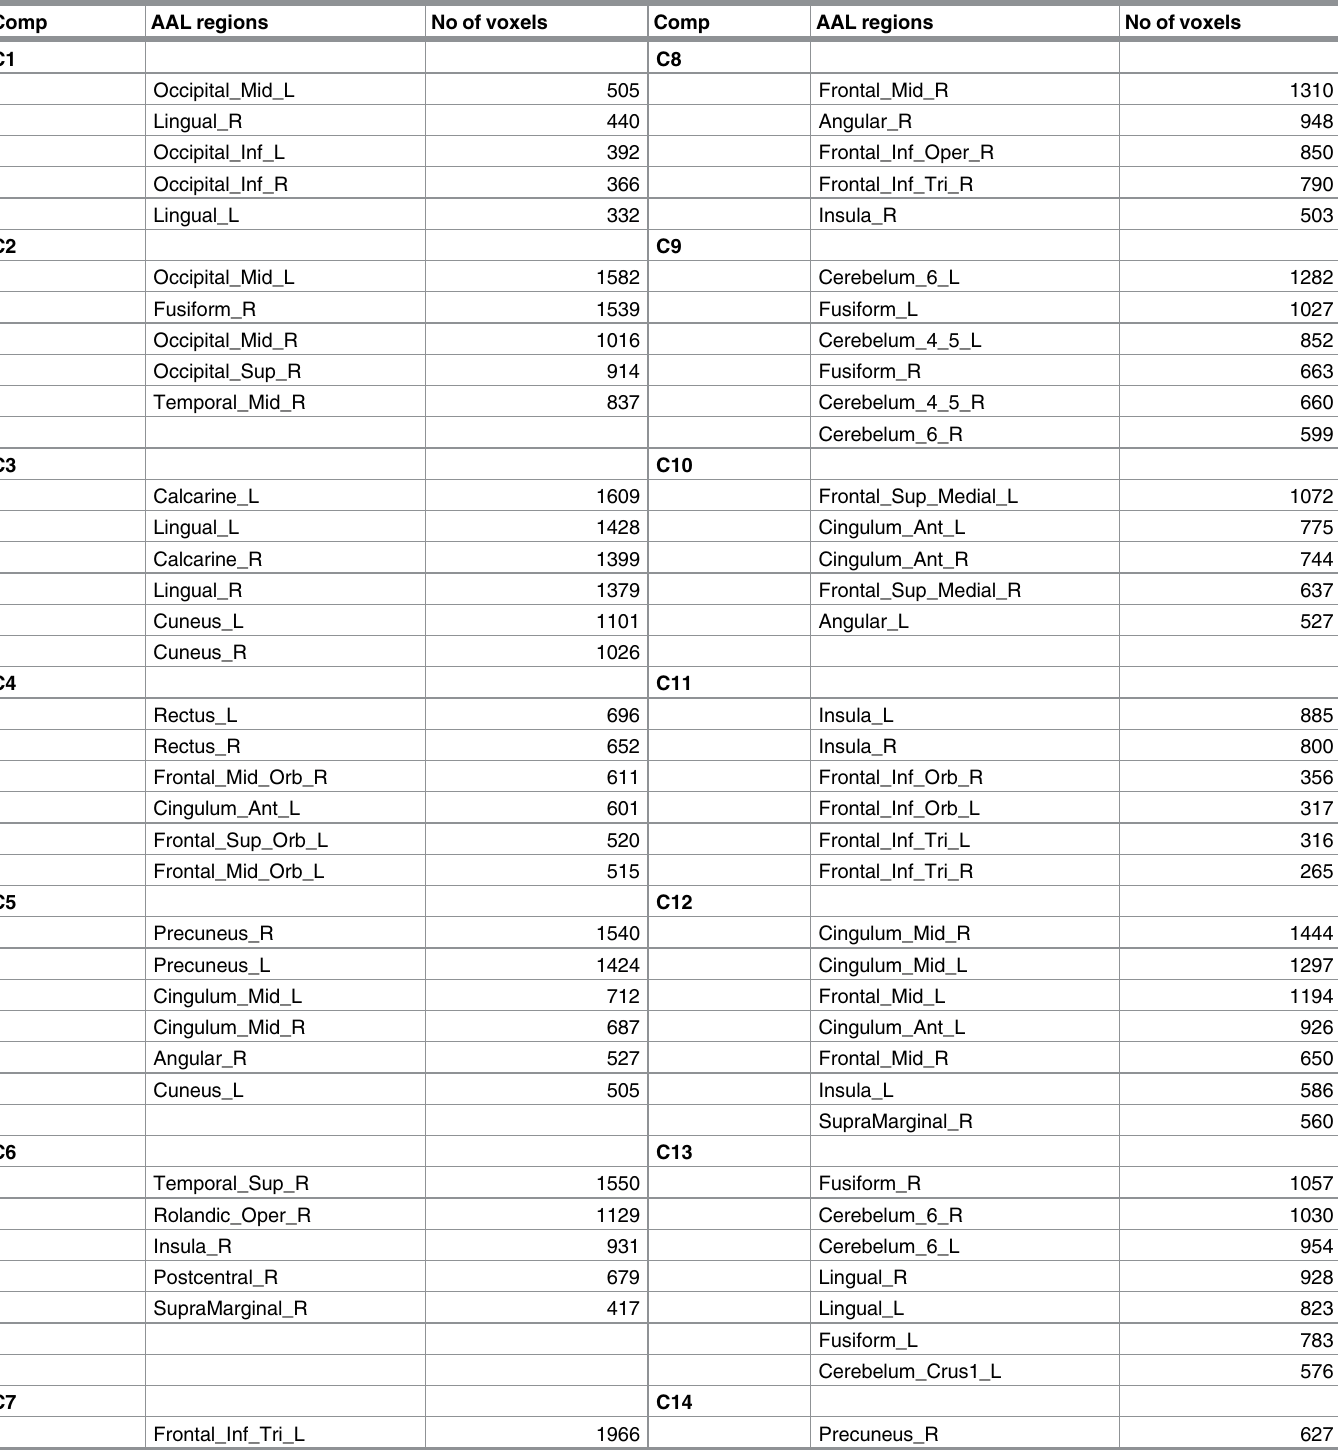
Table 4. Main brain regions comprised in the component maps. Top brain regionsincludedin the componentmaps as classifiedby AAL (automatic ana- tomic labelling)atlas (http://www.gin.cnrs.fr/AAL?lang=en) [36]. Labellingwas conductedon binary masks consistingof the overlapping regions of the